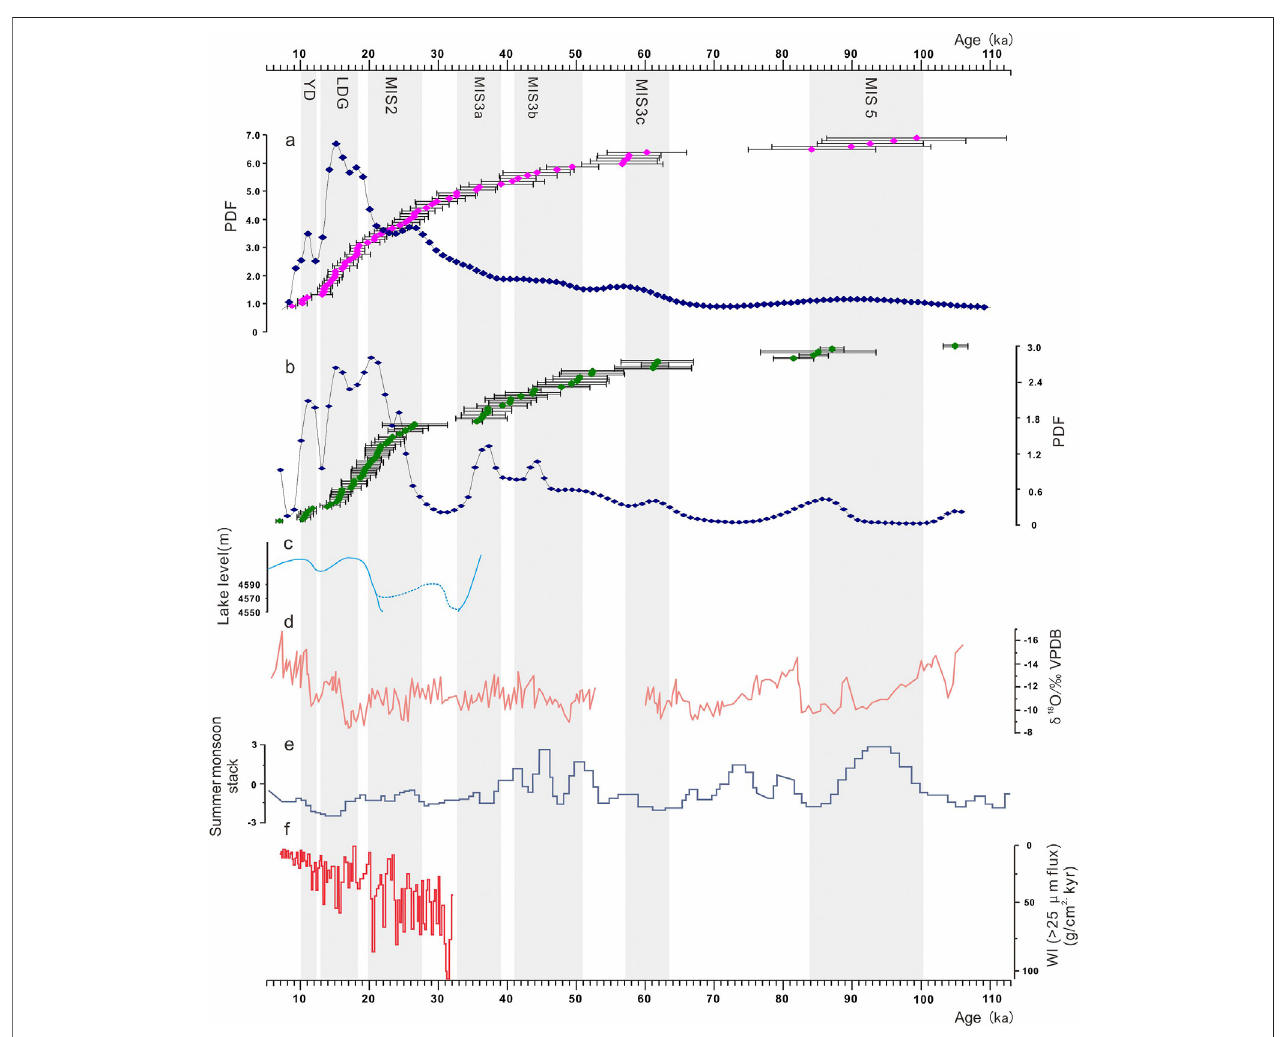
FIGURE 5 | Comparison of alluvial fan and glacial advance OSL ages from the present study with proxy climate indicators. (A) Purple rhombuses represent alluvial fan ages with error bars. (B) Green rhombuses represent glacial advance ages with error bars. The string of blue rhombus lines in (A) and (B) are the probability density function(PDF)curvesfromtheages. (C) ReconstructedlakelevelfortheTaroColakesystem,southwesternTP.Dashedlinerepresentstheprobablemaximumlakelevel (modi fi ed by Alivernini et al., 2018). (D) δ 18 O record of the stalagmites from the Xiaobailong cave, southwestern TP (Cai et al., 2015). (E) Arabian Sea summer monsoon stack (Caley et al., 2011; Bolton et al., 2013). (F) Qinghai Lake westerlies climate index (An et al., 2012). The gray frames represent the prominent increase stages of alluvial aggradations. MIS, Marne Isotope Stage; LDG, Last Deglaciation; YD, Younger Dryas event.